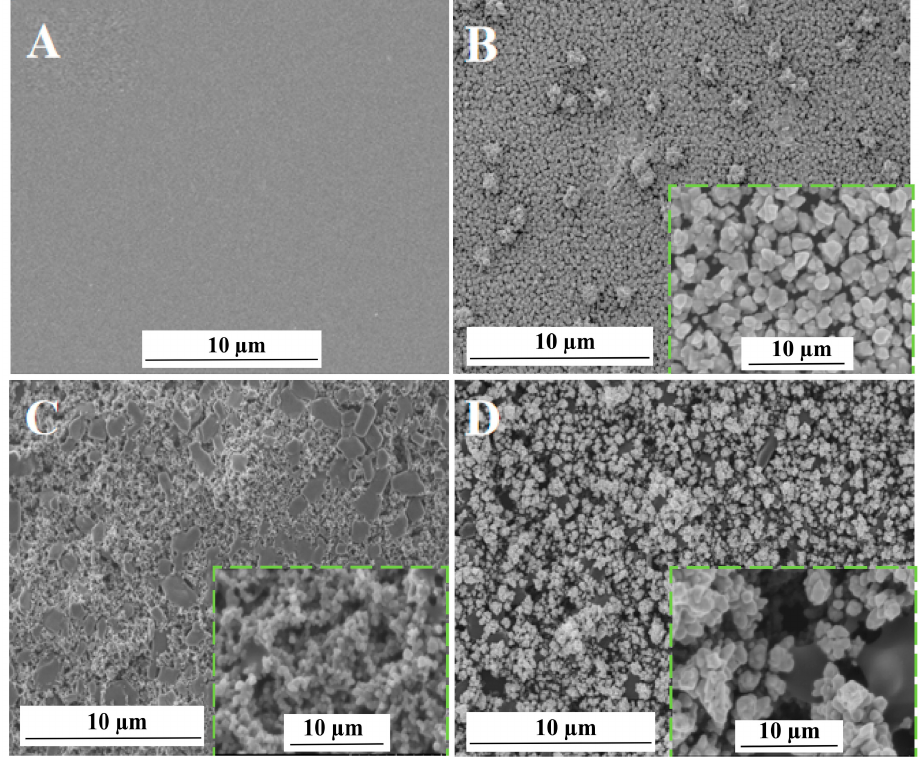
Figure 3. SEM images of bare GCE ( A ), AuNPs/GCE ( B ), AB − DHP/GCE ( C ) and AuNPs/AB − DHP/GCE ( D ).